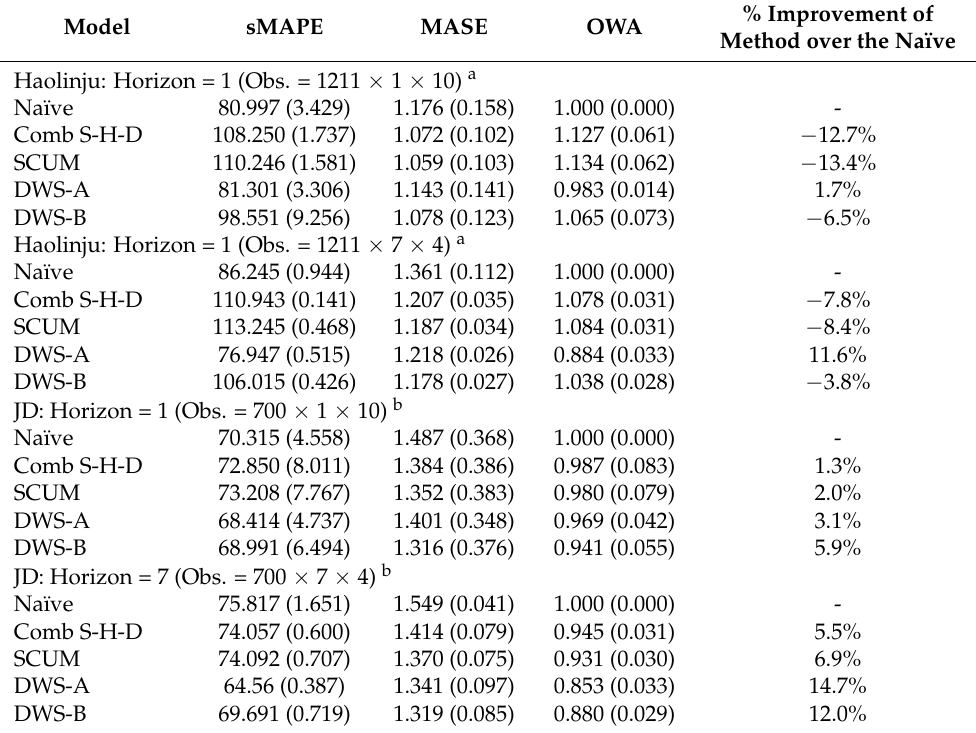
Table 6. The performance of the five methods for rolling forecast testing in the lumpy pattern.